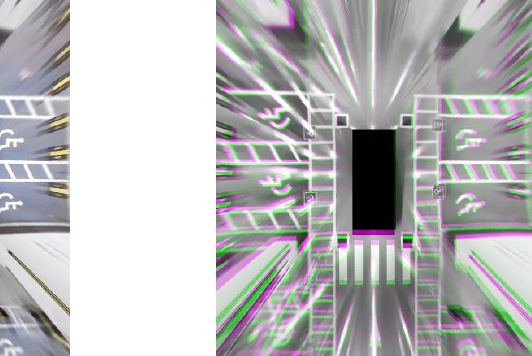
Figure 17. Experimental results of the proposed method and the conventional method. The magenta and green regions show where the grayscale intensities differ.